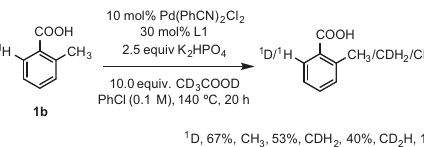
Fig. 6 Deuterium-labeling study. Deuterium-labeling experiment for the Pd(II)-catalyzed C – H lactonization (Note, this reaction was performed in the absence of O 2